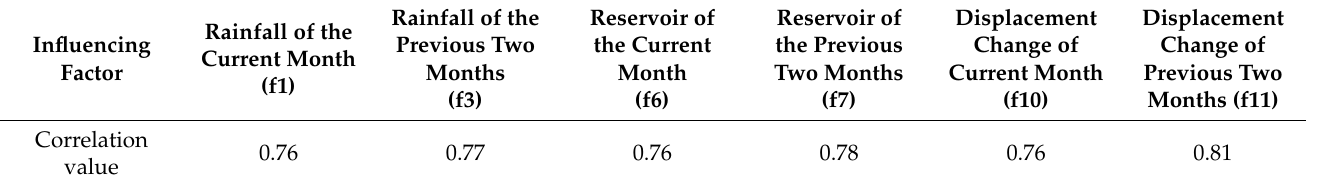
Figure 12. Grey correlation values of each environmental factor. Table 1. Grey correlation values between candidate influence factors and displacement components of the periodic term.